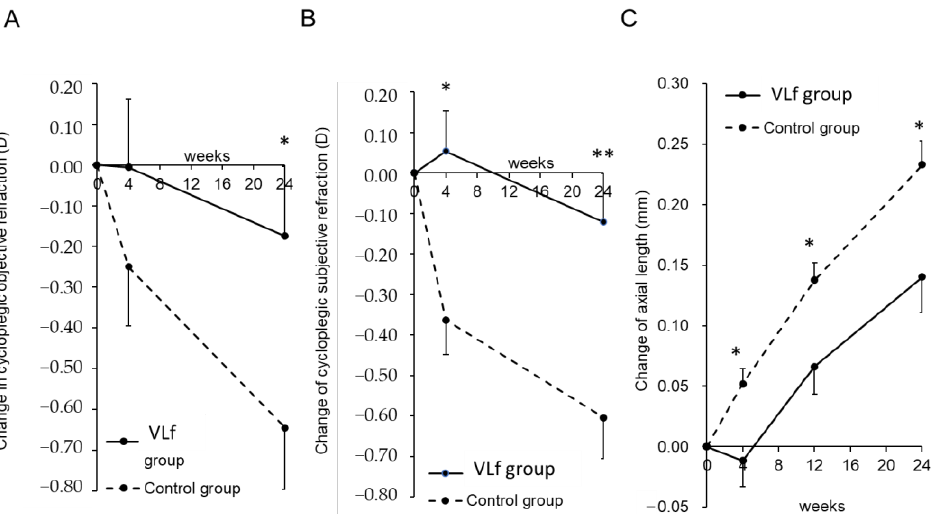
Figure 3. Time course of the changes in the adjusted mean cycloplegic objective and subjective spherical equivalent refractions (SER) and axial length elongation as a result of subgroup analysis in the subsequent subjects aged 8 to 10 years ( n = 30 eyes comprised of 10 and 20 eyes in the VLf and control groups, respectively). The results were obtained using a linear mixed-effects model analysis. The adjusted mean change in the cycloplegic objective SER in the VLf group is significantly ( p = 0.048) smaller than that in the control group at 24 weeks ( A ). The adjusted mean changes in the cycloplegic subjective SER in the VLf group are significantly ( p = 0.012 and p = 0.008) smaller than in the control group at 4 and 24 weeks, respectively ( B ). The adjusted mean changes in the axial length elongation in the VLf group are significantly ( p = 0.020, p = 0.015, and p = 0.016) smaller than in the control group at 4, 12, and 24 weeks, respectively ( C ). The black lines indicate the VLf group; the dotted lines indicate the control group. The error bars indicate the standard errors. * p < 0.05, ** p < 0.01. D, diopters. VLf: violet light eyeglasses frames.